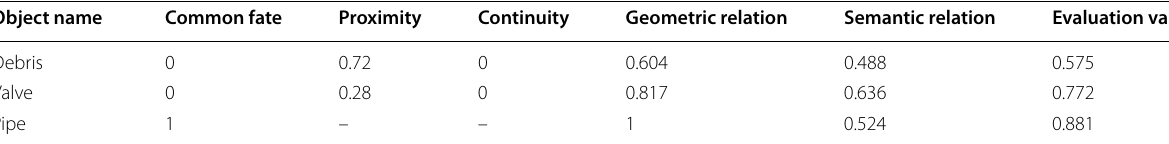
Table 9 Sentences created by LDA learning at Frame